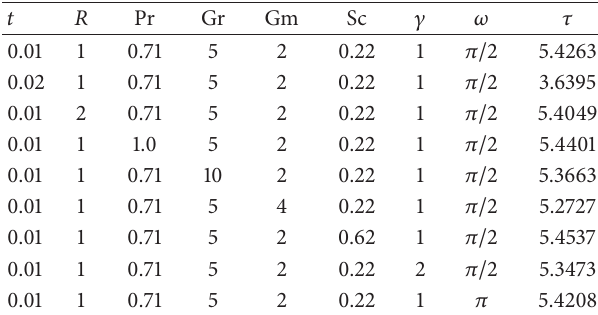
Table 1: Skin friction variation.